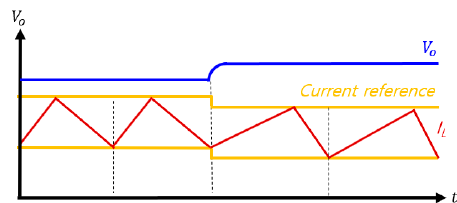
Figure 15. Inductor current due to changing output voltage.